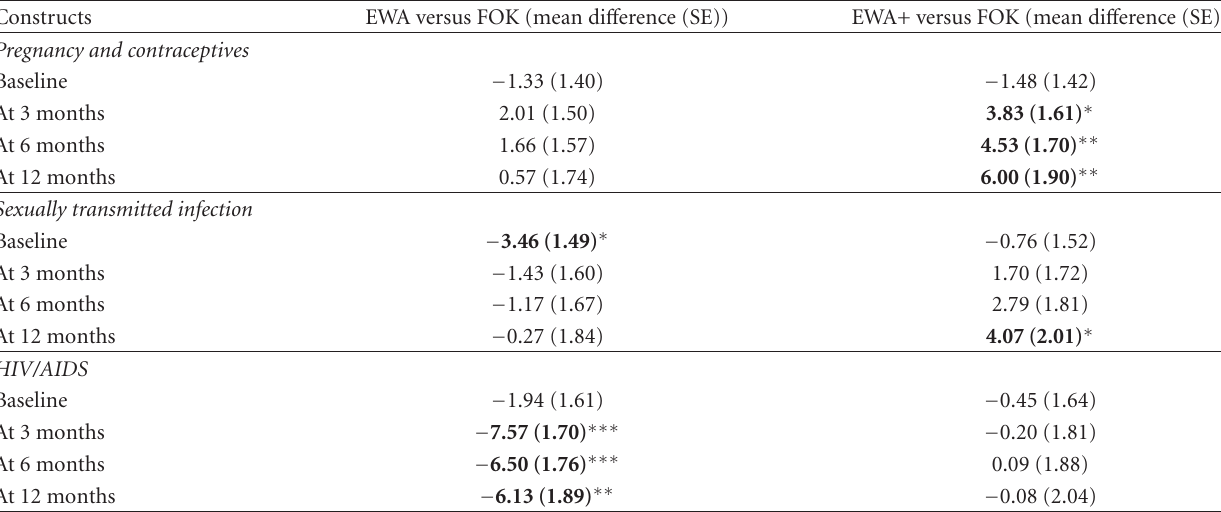
Table 5: Comparison of FOK and EWA/EWA+ intervention e ff ect on knowledge through 12-month followup a .